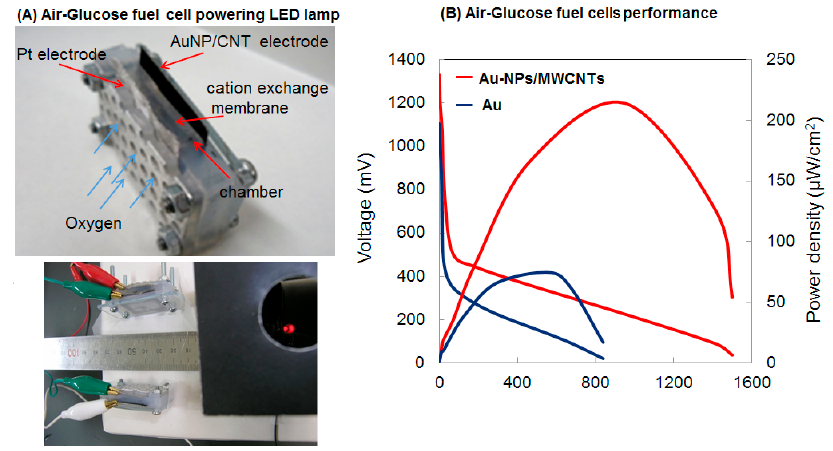
Figure 6. ( A ) Air-glucose fuel cell prototype and ( B ) its performance in terms of polarization and power density. Glucose concentration was 0.4 M in 0.3 M NaOH and 0.1 M PBS; temperature was 25 ° C. The working voltage of the LED lamp was 2 V. Reprinted with permission from ref. [66]. Copyright 2011, Elsevier.